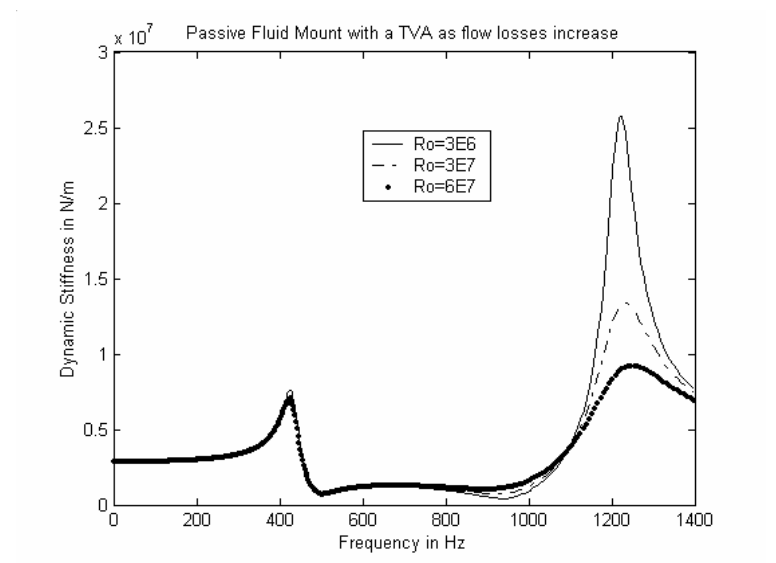
Fig. 14. Dynamic stiffness as a function of damping (fluid losses).